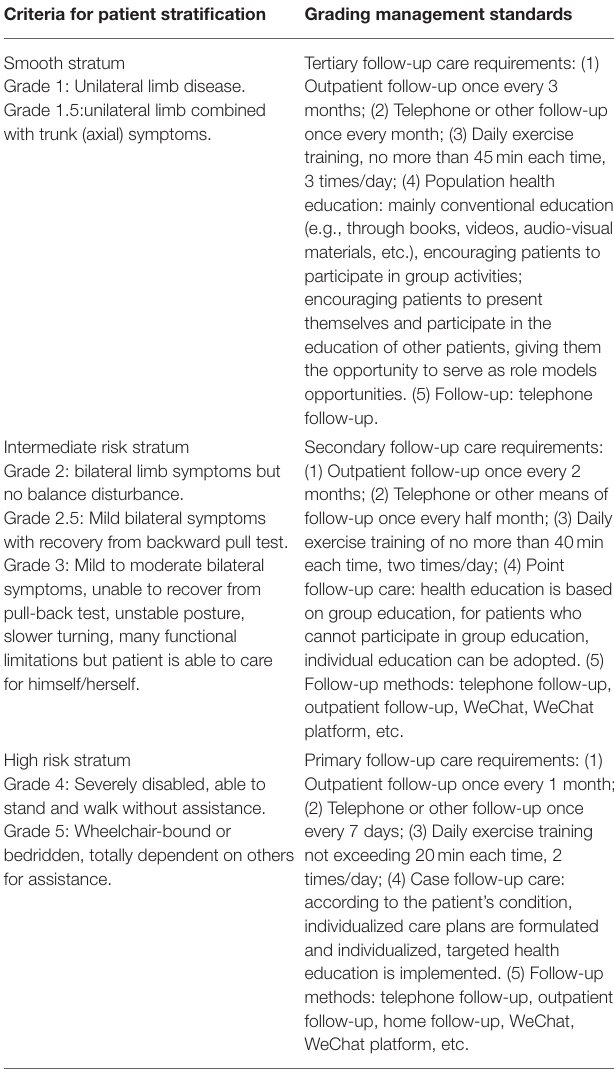
TABLE 1 | Stratified and graded management criteria for ambulatory PD patients. Criteria for patient